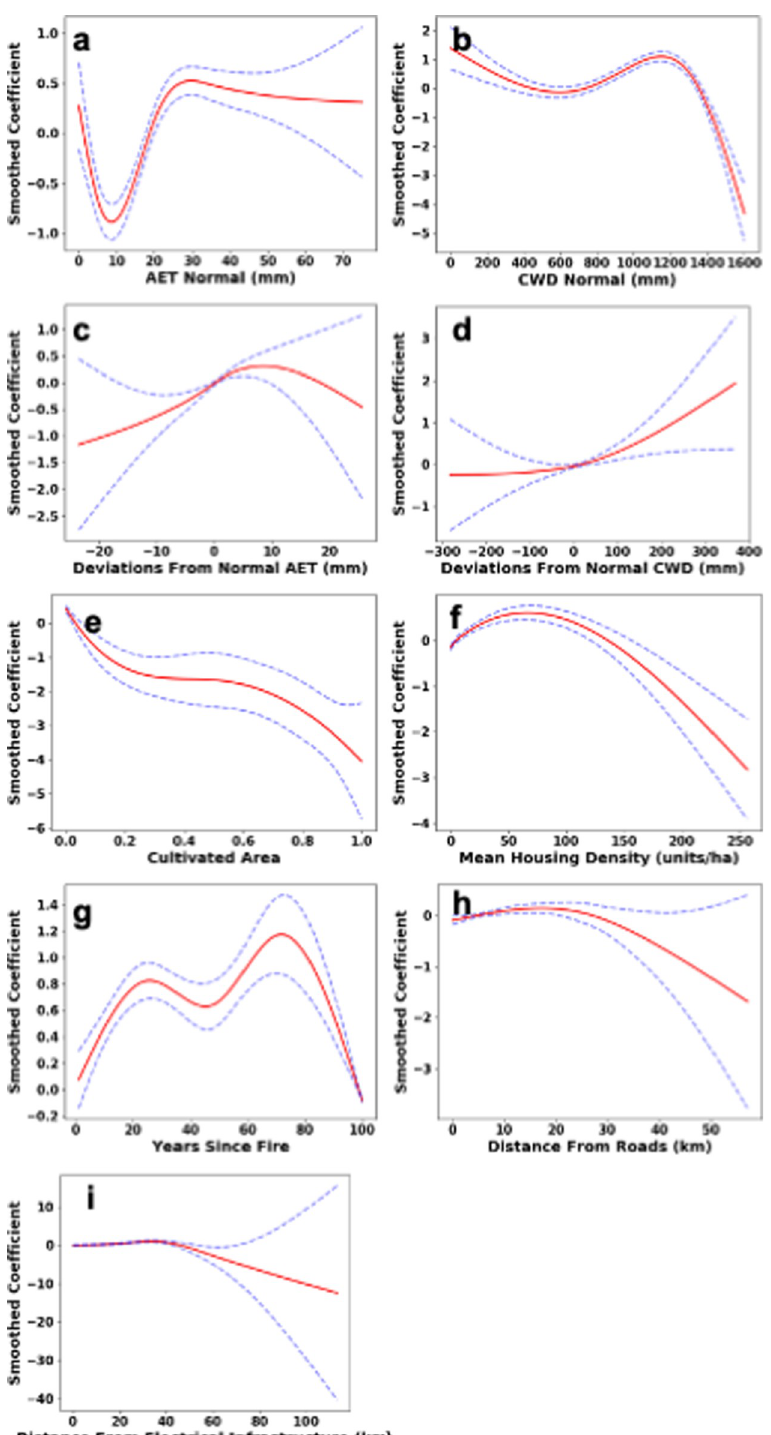
Fig 5. Smoothed coefficients for the statewide generalized additive model. Coefficients include (a) 1951–1980 normal actual evapotranspiration, (b) 1951–1980 normal climatic water deficit, (c) annual deviations from 1951–1980 normal actual evapotranspiration, (d) annual deviations from 1951–1980 normal climatic water deficit, (e) proportion of cultivated area, (f) annual mean housing density, (g) years since fire, (h) distance from roads, and (i) distance from electrical